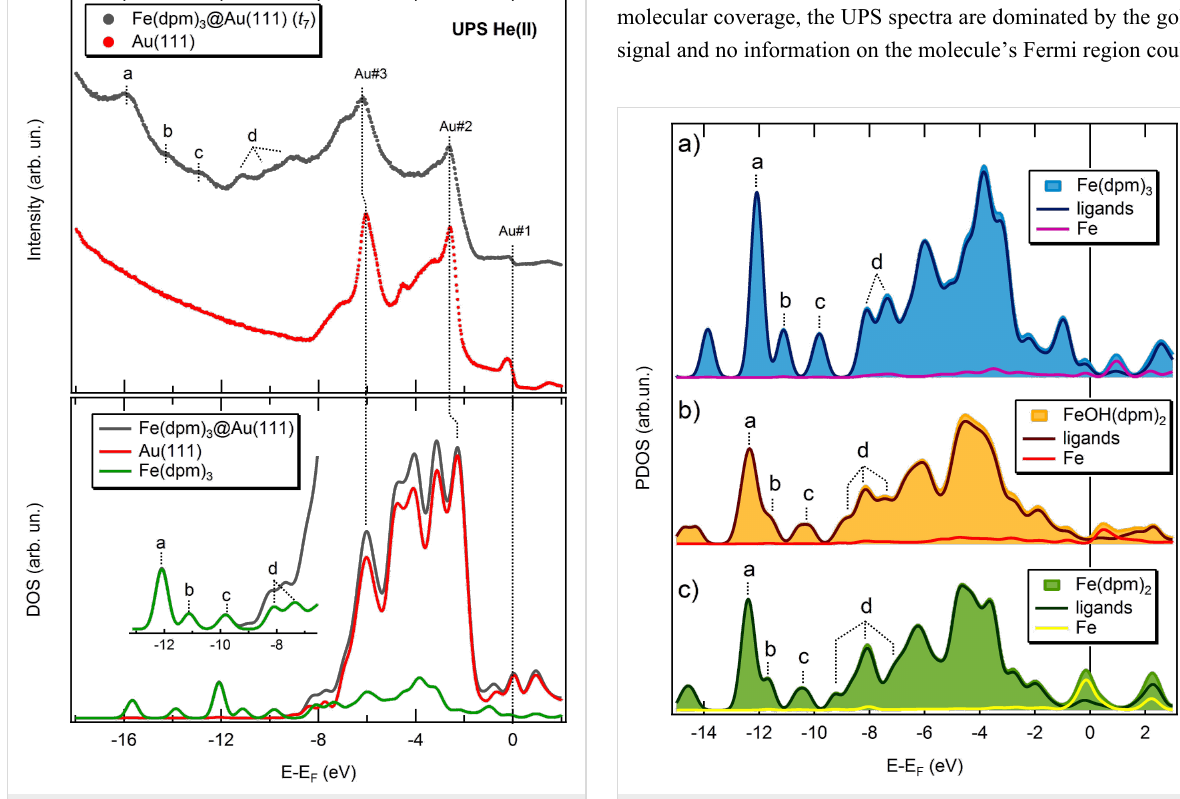
Figure 2: (Top panel) UPS spectra relative to the Fe(dpm) 3 saturation coverage (grey curve) and the clean substrate (red curve). (Bottom panel) Theoretical density of states for the system Fe(dpm) 3 @Au(111) (grey curve) and decomposition into Au and Fe(dpm) 3 contributions.